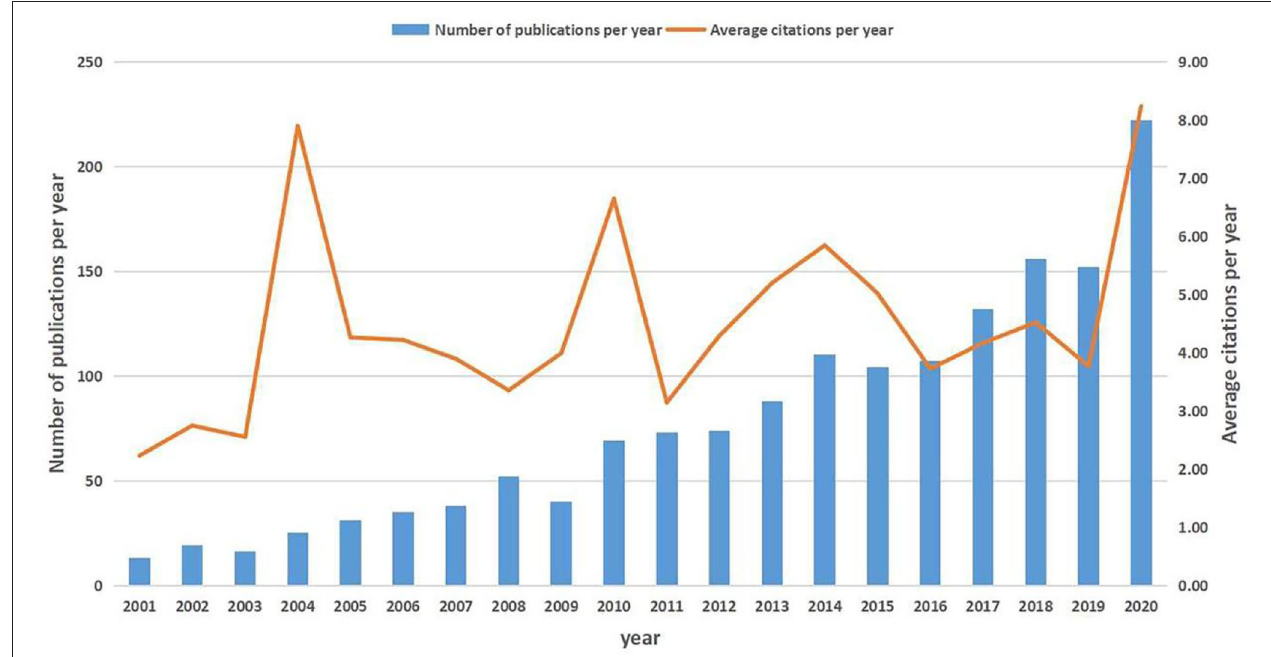
FIGURE 1 | The number of annual publications on SAE research from 2001 to